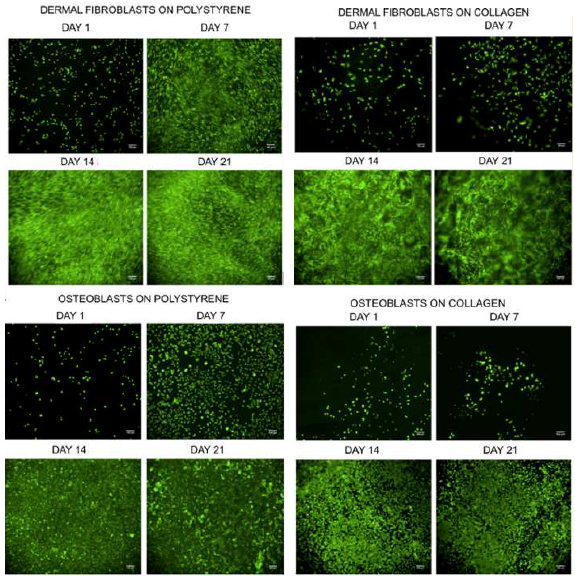
Figure 1. Dermal fibroblasts and osteoblasts culti- vated on polystyrene and collagen were stained with calcein AM solution, green color signifies metabolically active cells (scale 100 µ